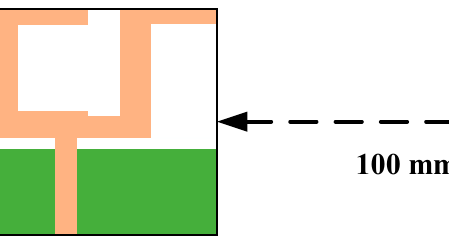
Figure 16. Side-by-side configuration.